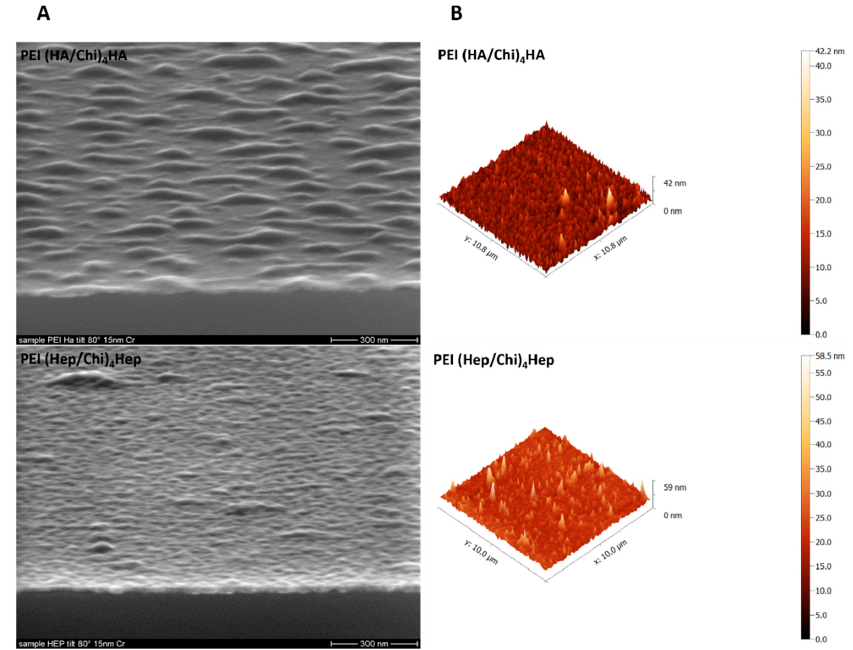
Figure 3. ( A ) Scanning electron microscopy (SEM), Scale bar: 300 nm and ( B ) atomic force microscopy (AFM) for studying topography of samples poly (ethylene imine) (PEI) and terminal layers of polyelectrolyte multilayers (PEMs) composed of either hyaluronic acid (HA) or heparin (Hep) as polyanions and chitosan (Chi) as polycation abbreviated as (PEI(HA / Chi) 4 HA, PEI(Hep / Chi) 4 Hep),